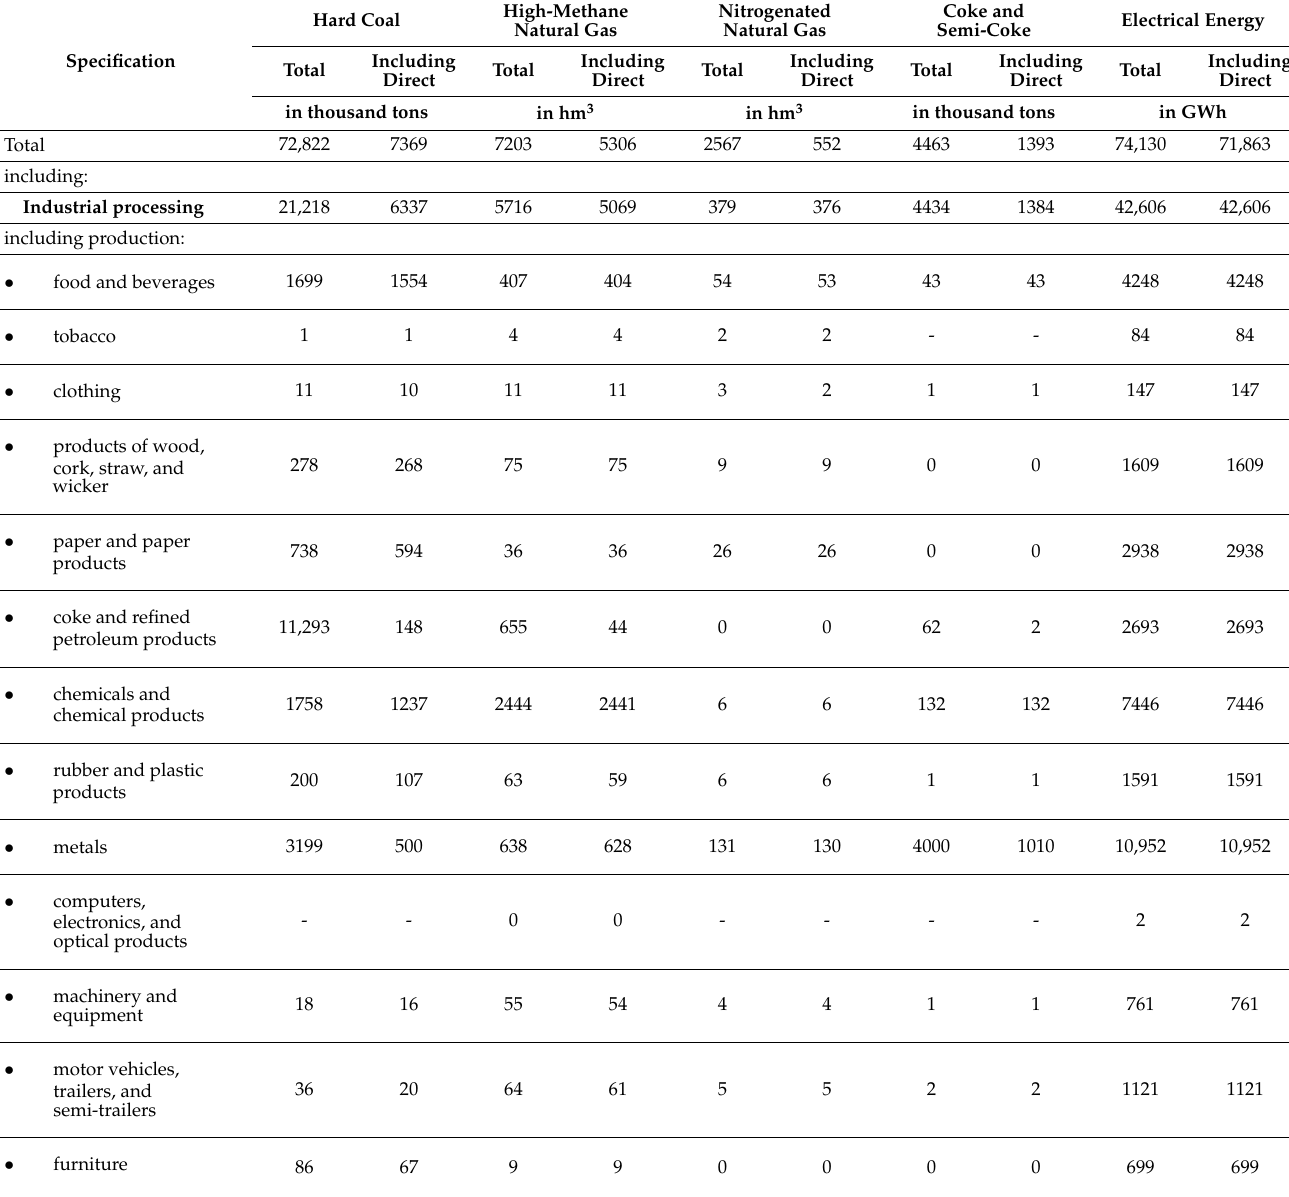
Table 2. Consumption of certain fuels and electricity in industry by selected sections in